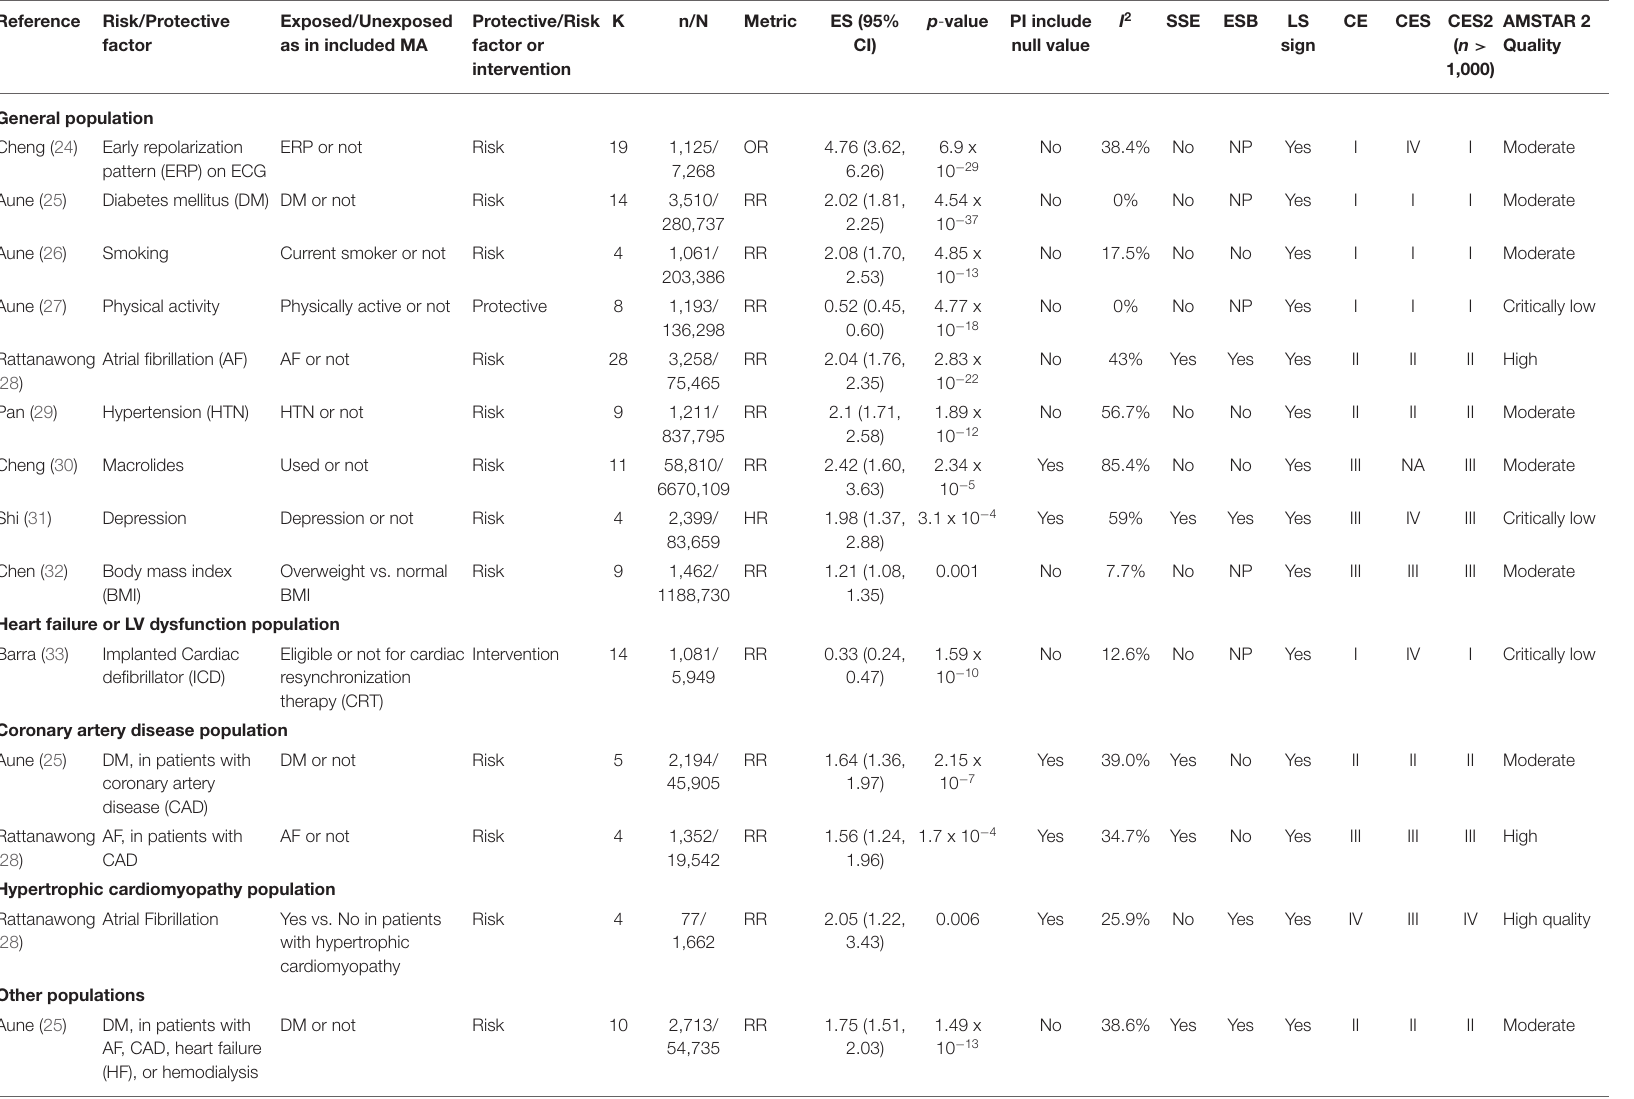
TABLE 1 | Risk and protective factors of sudden cardiac death, in meta-analyses of observational studies. Reference Risk/Protective Exposed/Unexposed factor as in included